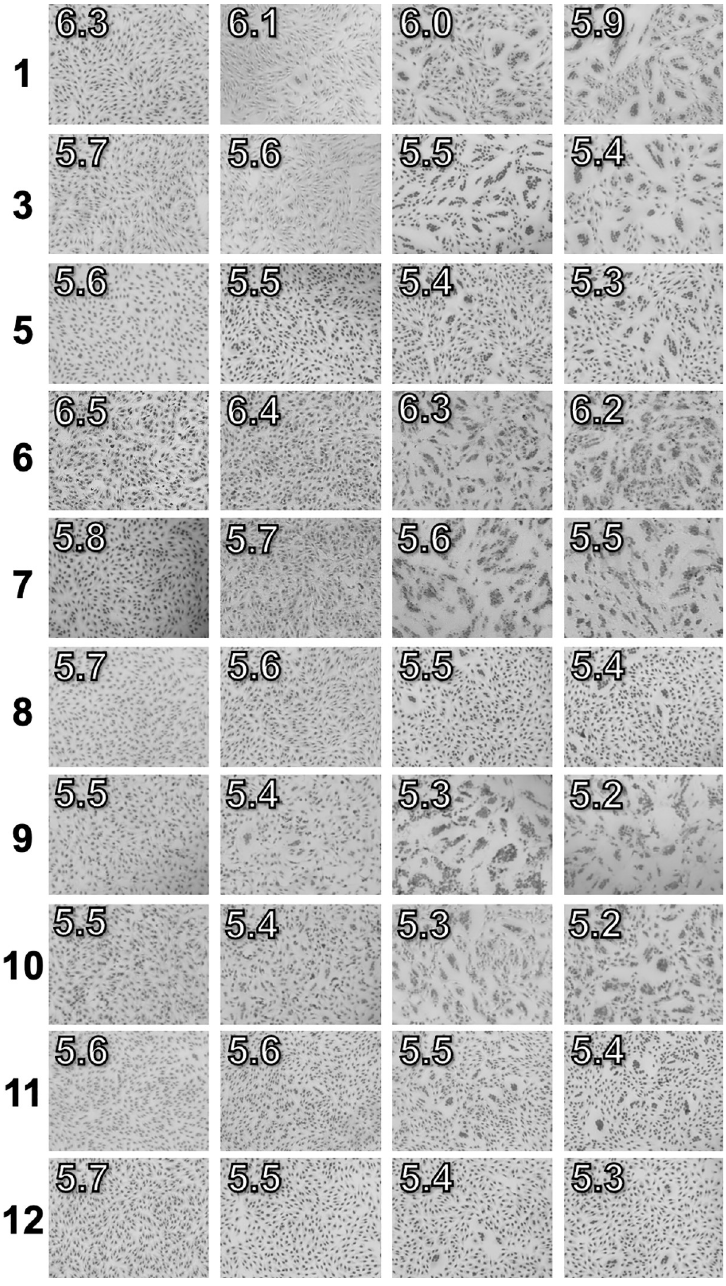
Fig 5. HA activation pH values measured by syncytia formation assay. Viruses identified by the numbers on the left side of each row ( cf . Table 1) were inoculated into Vero cells at an MOI of 3 PFU/cell. The pH values for PBS overlaid onto the cells are reported on the top left of each microscopic image. HA activation pH was defined as the highest pH at which syncytia formation occurred (third column). To examine the relationship between thermal and acid stability for IAVs that differ geneti- cally, thermal inactivation and associated 90% Rt values at 55˚C were measured for twelve swine IAV isolates (Fig 9). For these genetically distinct swine viruses, 90% Rt values at 55˚C did not correlate with virus inactivation pH (Fig 9E, R 2 < 0.01) and HA activation pH (Fig 9F,